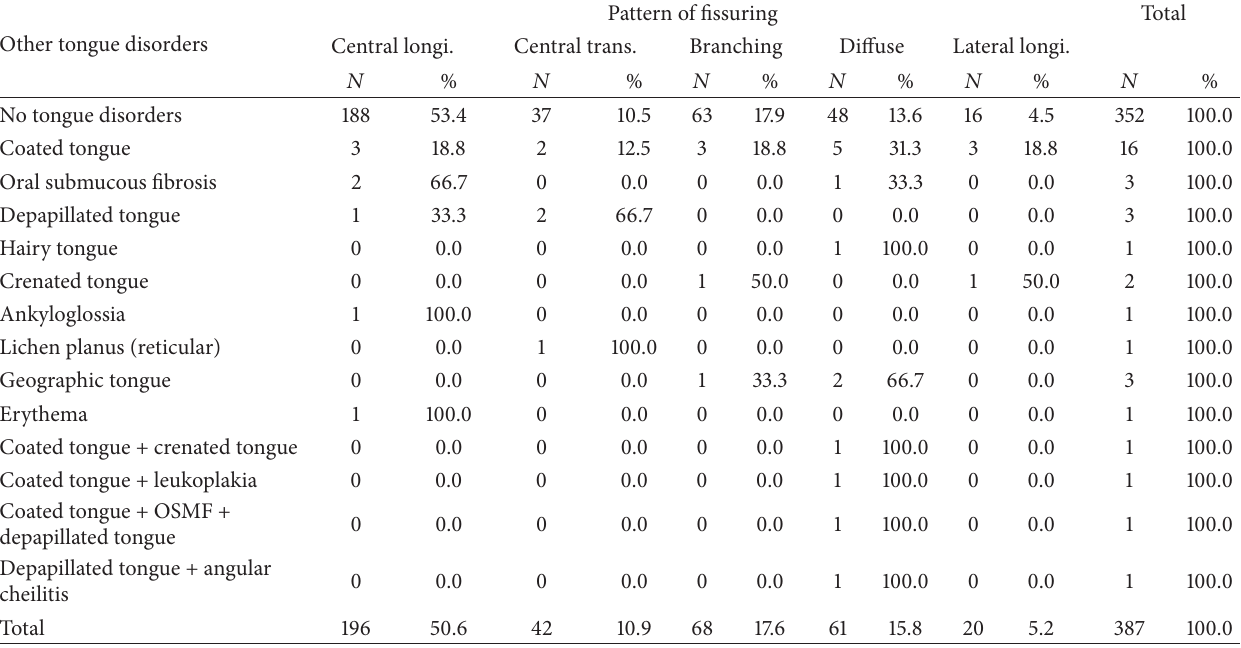
Table 2: Correlation between pattern of fissuring and other tongue